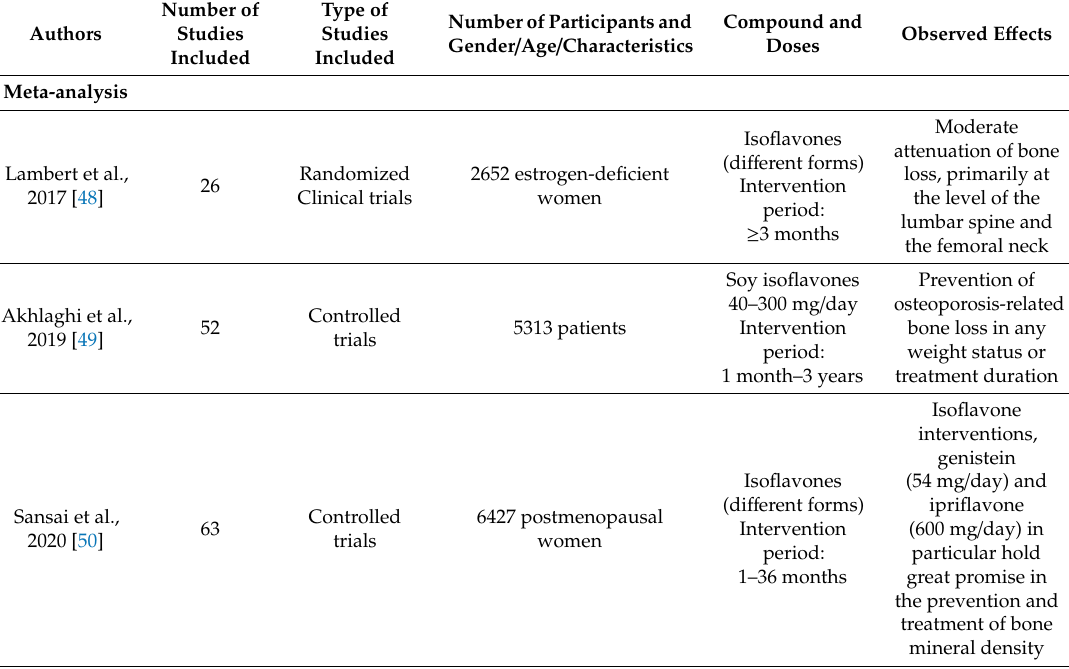
Table 2. E ff ects of isoflavones in bone health